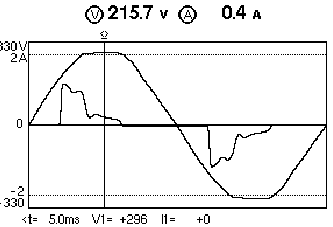
Figure 14. The phase voltage and the neutral current for a compact fluorescent lamp (set 4).